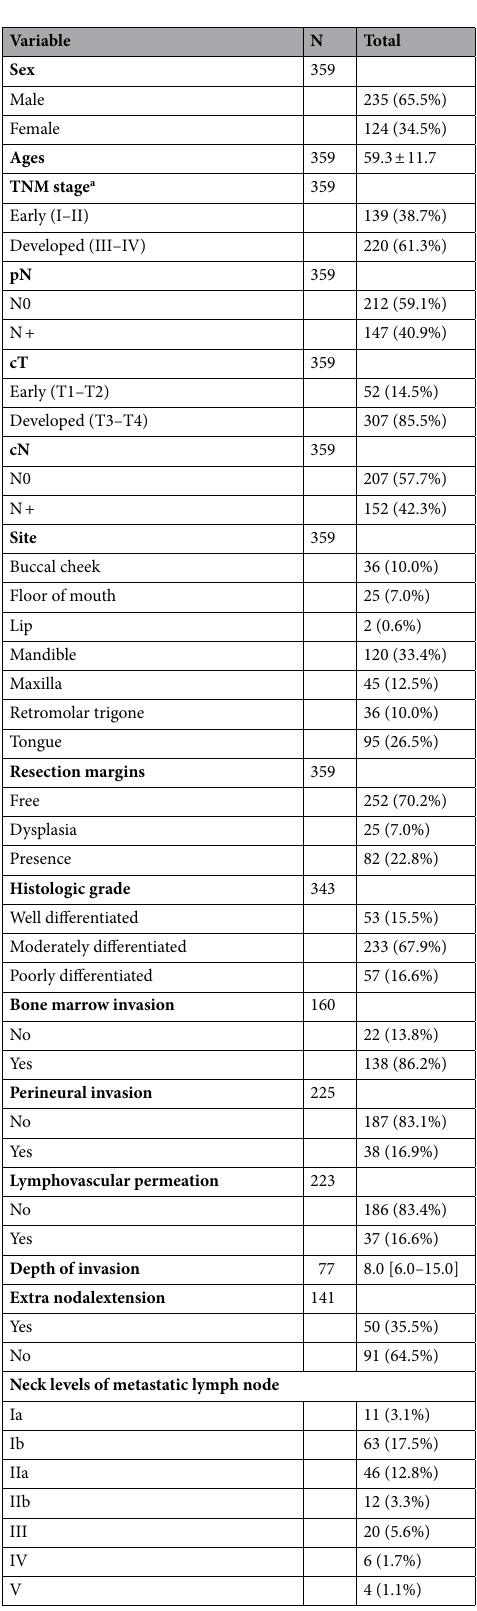
Table 1. Baseline characteristics. Data were reported as mean ± standard deviation (SD) or median [Q1– Q3] for continuous variables and n (%) for categorical variables. a According to AJCC 8th classification. pN pathologic N, cT clinical T, cN clinical